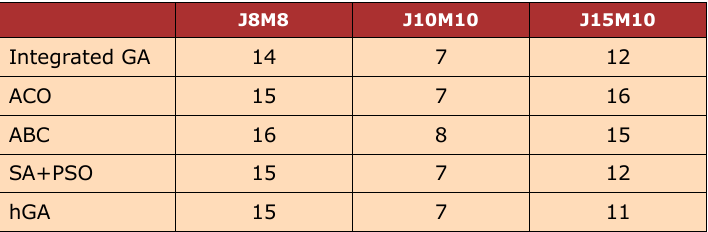
Table 1. Result of integrated GA for FJSP